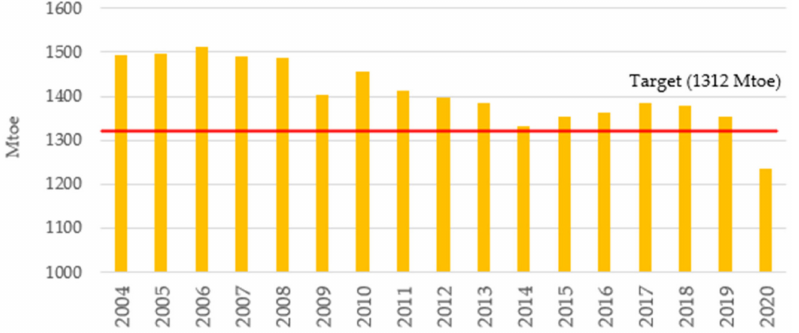
Figure 3. Primary energy consumption and implementation of the target in the EU, 2004–2020. Source: [48].